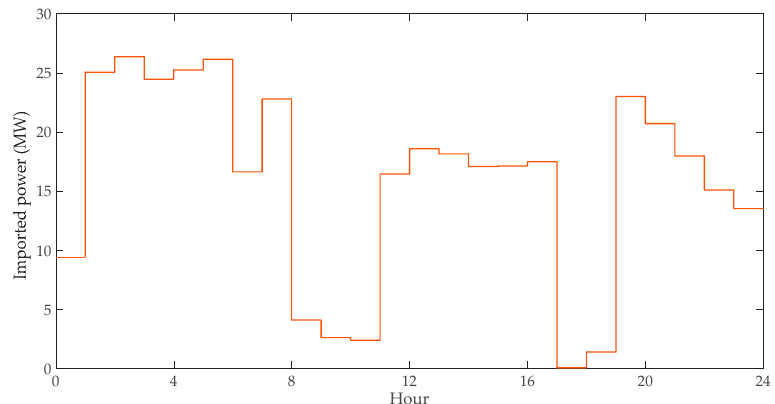
Figure 9. Active power imported from the whole µG along a day of the first year of the planning period.